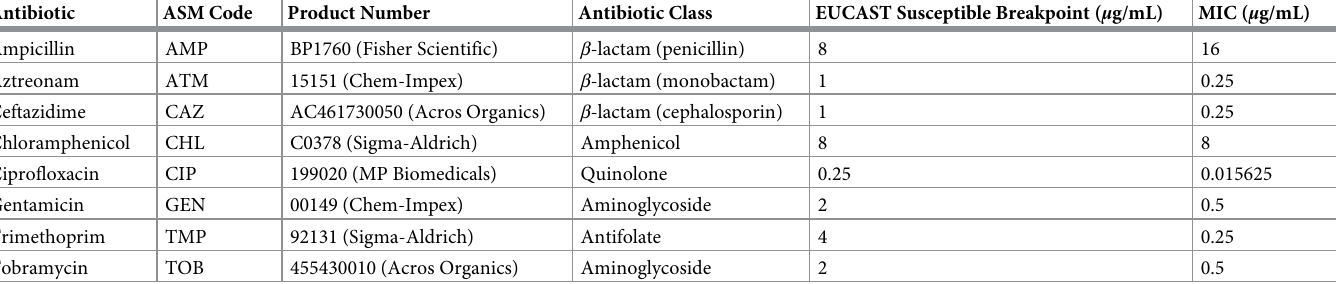
Table 1. The eight antibiotics chosen for our studies, including EUCAST susceptible breakpoints [28] and experimentally determined MICs for E. coli strain MG- 1655. Antibiotic ASM